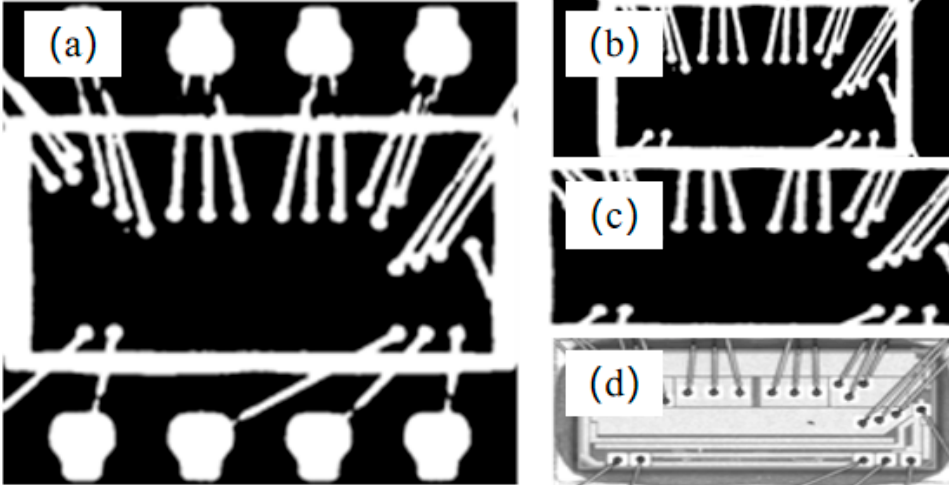
Figure 9. Images obtained during template matching using improved NCC. Binary image obtained via ( a ) approximate matching in X-direction and ( b ) accurate matching in Y-direction. ( c ) Binary